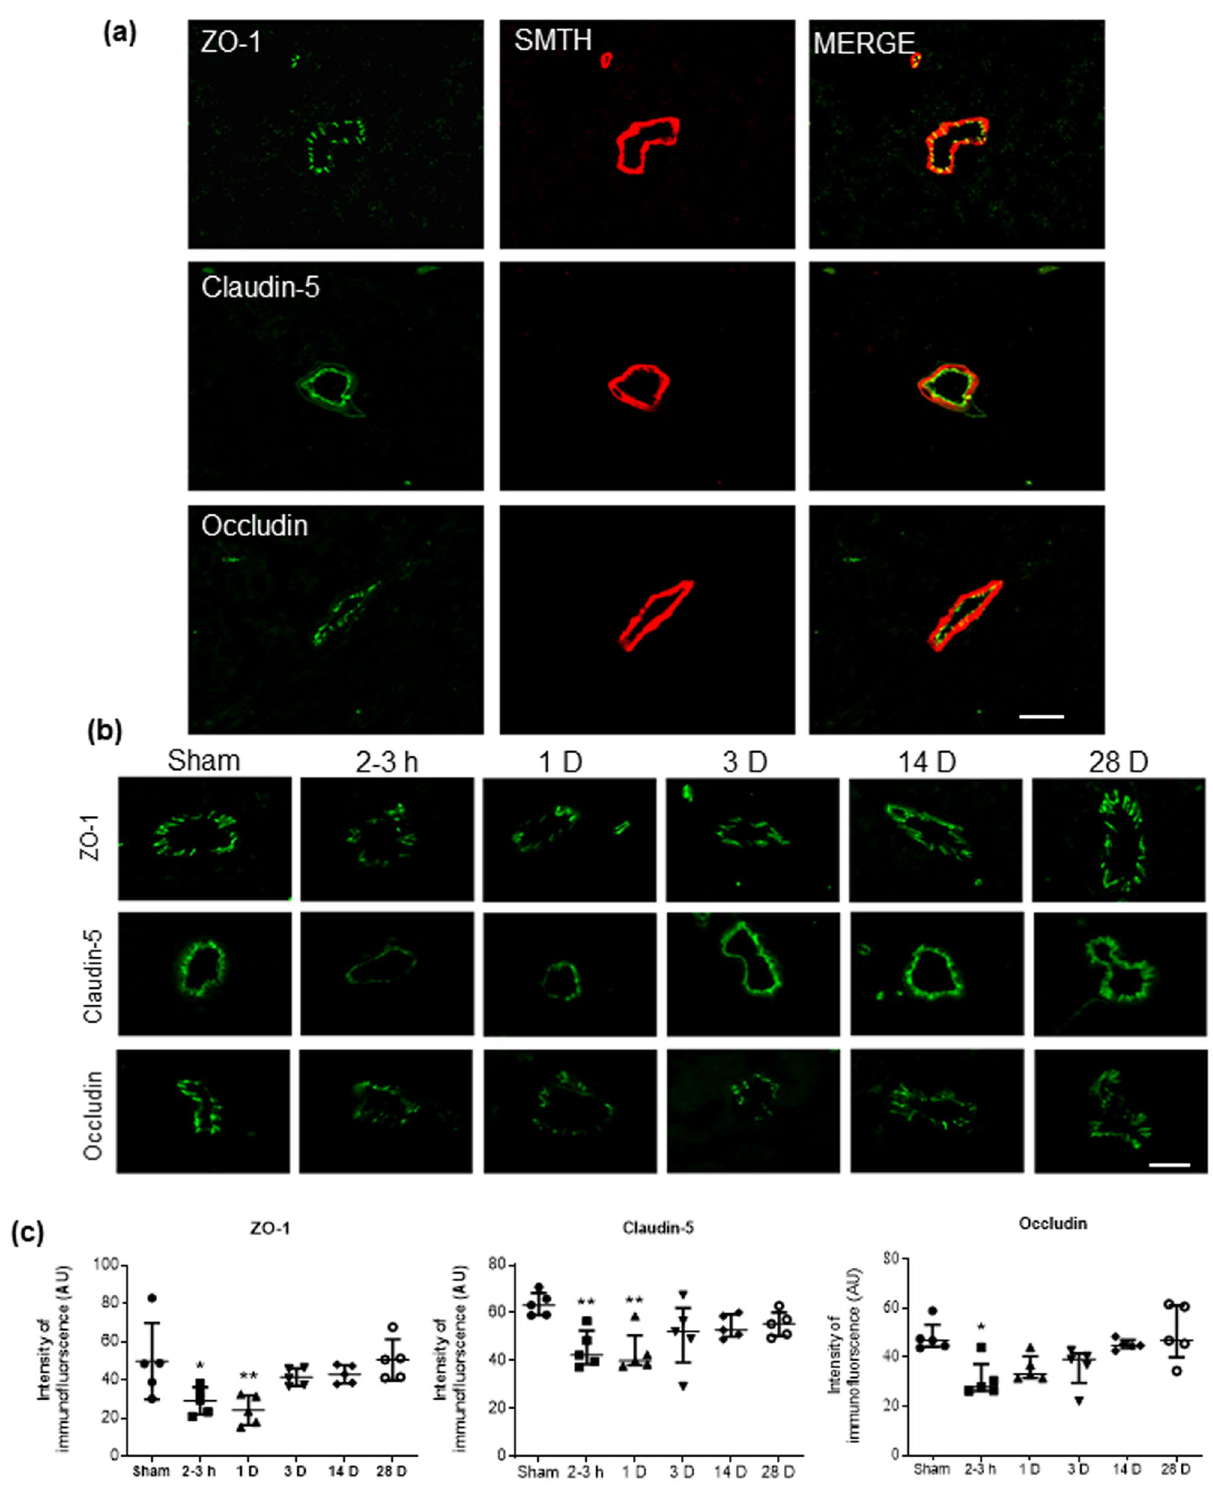
Figure 3. Decrease in the expression of tight junction (TJ) proteins in cortex was induced by BOP. ( a ) Co-localization of TJ proteins ZO-1, claudin-5, and occludin with SMTH, the blood vessel smooth muscle marker in sham rats. ( b ) Immunofluorescent images of TJ proteins in sham and blast-exposed rats at different time points post-BOP. ( c ) Immunofluorescence intensity assessment of TJ proteins in sham and blast-exposed rats. BOP induced significant reduction in the expression of TJ proteins at 2 h and 1D after exposure, followed by an increasing trend towards sham levels at later time points. Scale bar in ( a ) 25 μm. Data are mean ± SD, * p < 0.05, ** p < 0.01 for comparison of the specified time point post-blast with